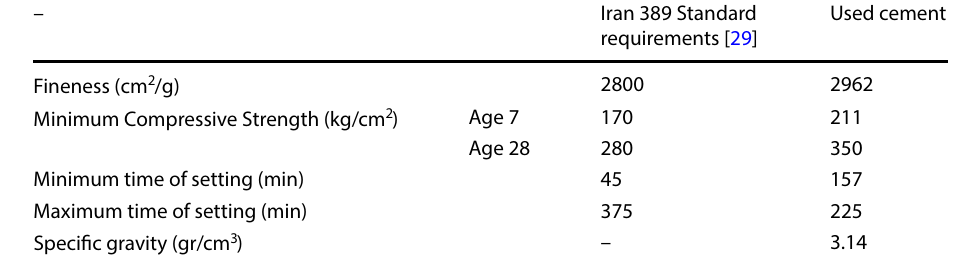
Table 3 Cement characteristics